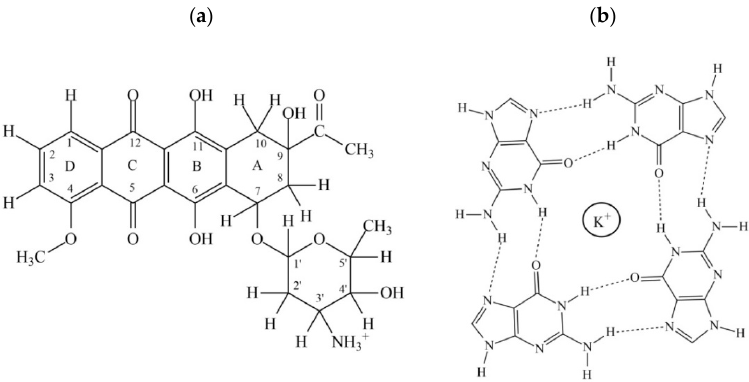
Figure 1. ( a ) Chemical structure of daunomycin and; ( b ) G-tetrad in the presence of K +